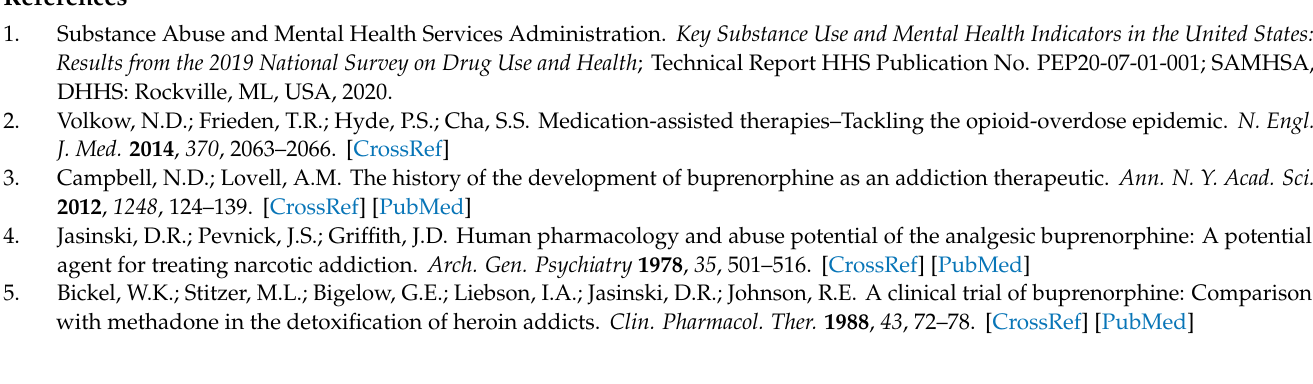
Study Inclusion Criteria; Table S3: Study Exclusion Criteria I; Table S4: Study Exclusion Criteria II; Table S5: Demographics of Screened Individuals; Table S6: Sociodemographics of the Analysis Sample; Table S7: Drug Use History of the Analysis Sample; Table S8: Daily Dose, Urinalysis Days, and Time-Weighted Dose of a Single